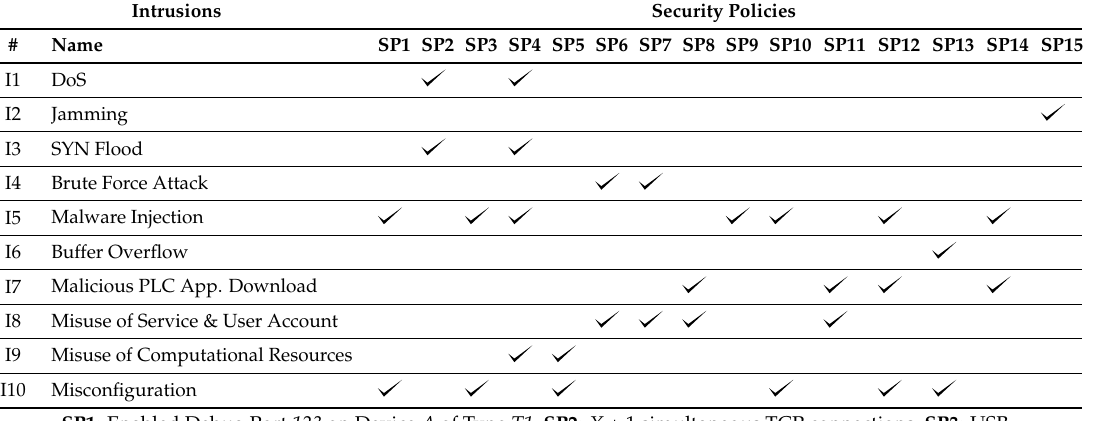
Table 4. Mapping between examples of intrusions and their corresponding security